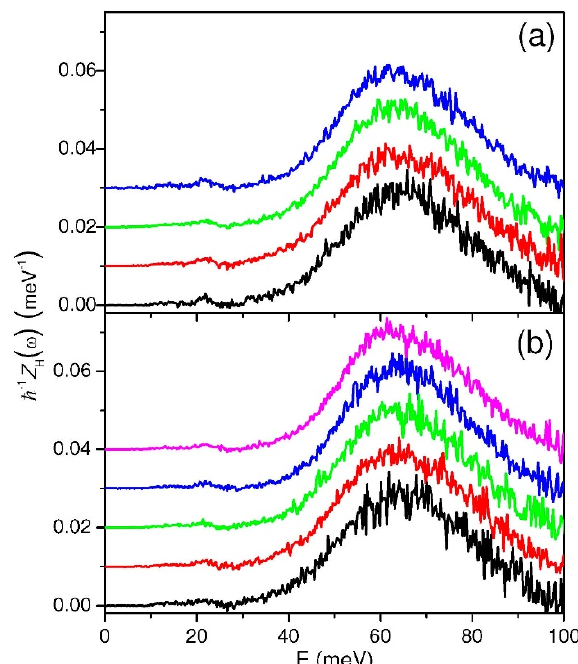
Figure 1. Experimental determinations of the H-projected vibrational densities of states, Z H ( ω ), for the samples reported in Table 1. Panel ( a ) contains data taken at p = 1 bar and T = 453 (black), 413 (red), 373 (green), and 333 K (blue). Panel ( b ) contains data taken at p = 2 bar and T = 453 (black), 413 (red), 373 (green), and 333 K (blue) plus at p = 4 bar, T = 333 K (magenta). Curves have been vertically shifted for graphic reasons.